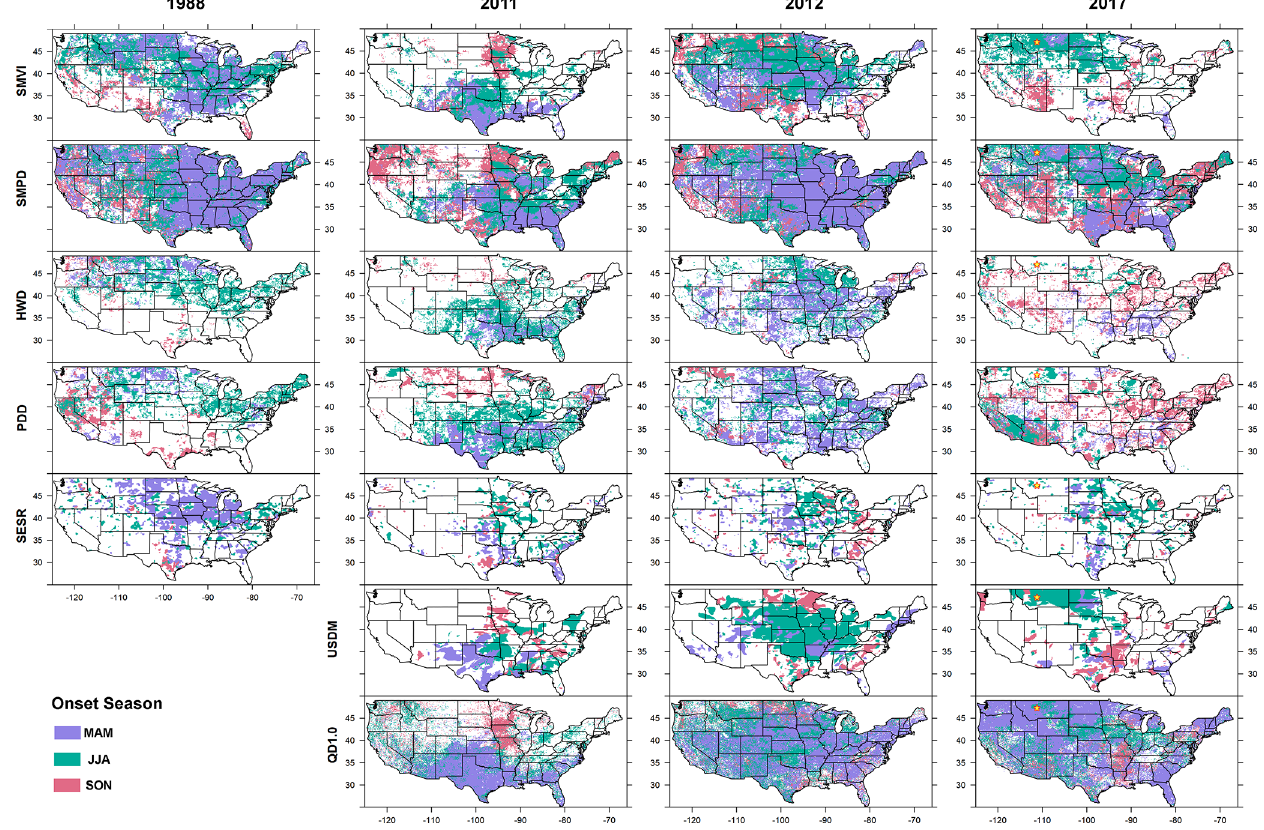
Figure 6. Flash drought onset maps as captured by different definitions for the years 1988, 2011, 2012, 2016, and 2017. USDM and QD1.0 are available since 2000. The yellow star within Montana on the 2017 panels represents the selected grid point in Fig.